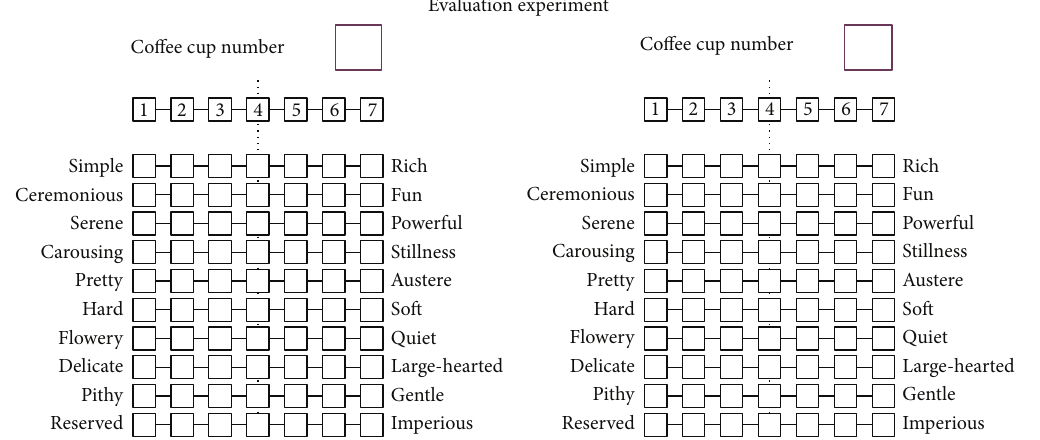
Figure 6: Questionnaire for data collection.